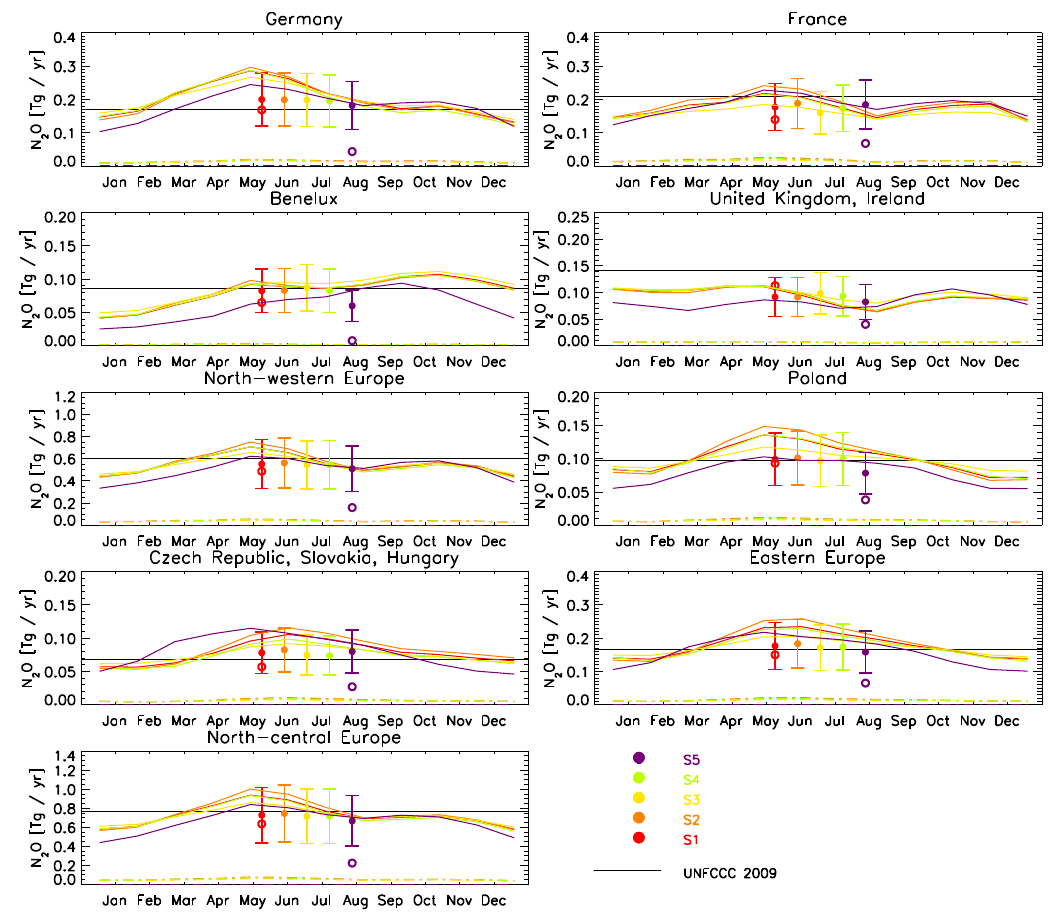
Fig. 5. Total emissions for various northwest European and east European countries for 2006 (see also Table 5). The filled colored circles represent the annual total emissions from the 5 inversions and open circles are the applied a priori emissions. The small natural emissions have been subtracted for S1–S4 (while this is not possible for S5, which does not use any detailed a priori knowledge). Emissions reported to UNFCCC are shown by the black solid line (uncertainties of the order of 150% are not shown here, but compiled in Table 6). North-western Europe represents the sum for Germany, France, Benelux, United Kingdom and Ireland, while Eastern Europe represents the sum of Poland, Czech Republic, Slovakia, and Hungary. Finally North-central Europe represents the sum of all considered countries. Colored solid lines represent the seasonal variation of anthropogenic emissions derived in the inversions (3 month running mean), while the colored dash-dotted lines show the small contribution from natural